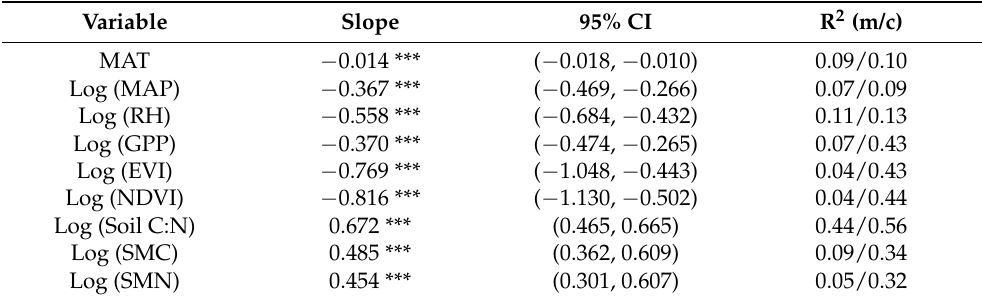
Table A2. Statistics of GLMM relating environmental variables with subsoil τ , treating the sites as a random effect. Variable Slope